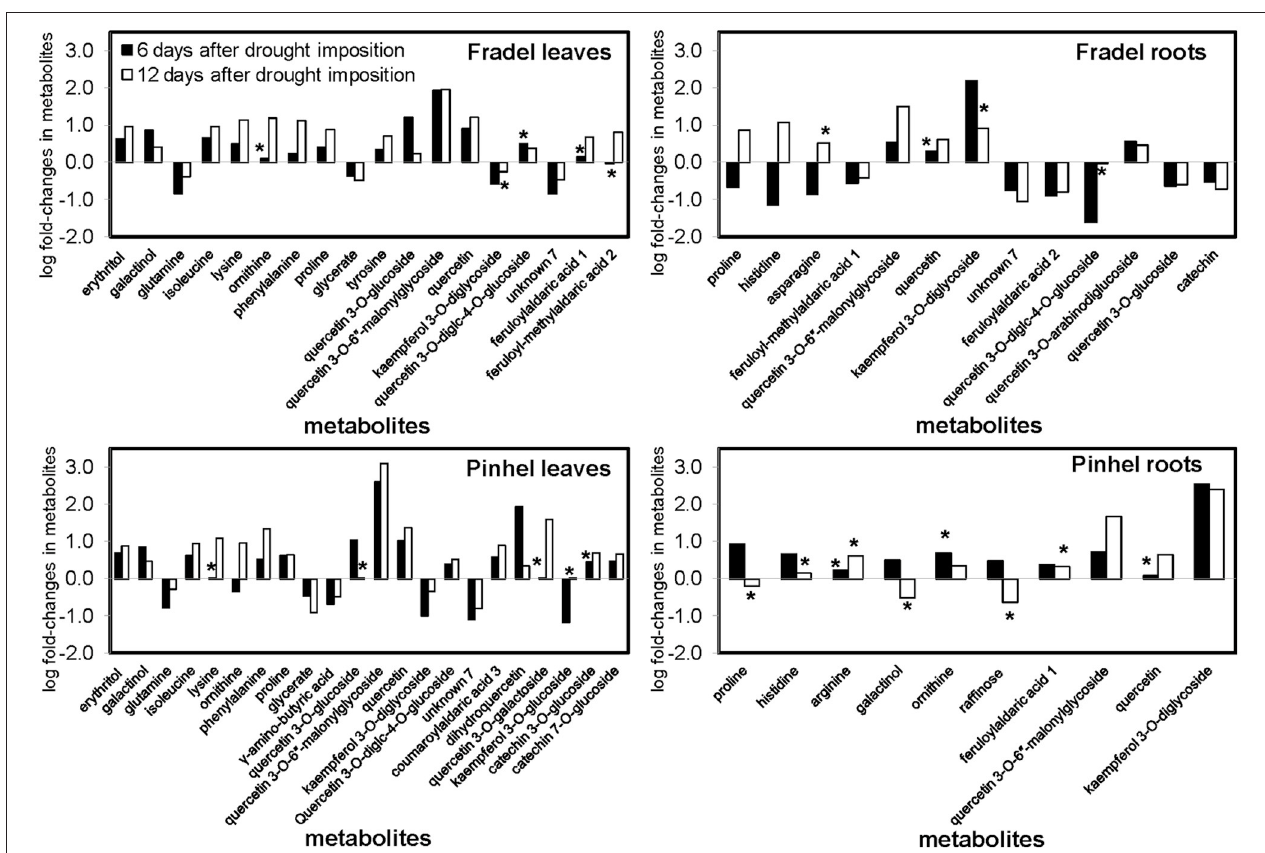
FIGURE 3 | Comparison of metabolite changes in cowpea in response to 6 and 12 days of drought stress. Log fold-changes were determined relative to the control. Only metabolites that showed at least a 0.5-fold change at day 6 or day 12 are displayed. Metabolites marked with * were not statistically different between well-watered and drought-stressed conditions ( t -test, P <